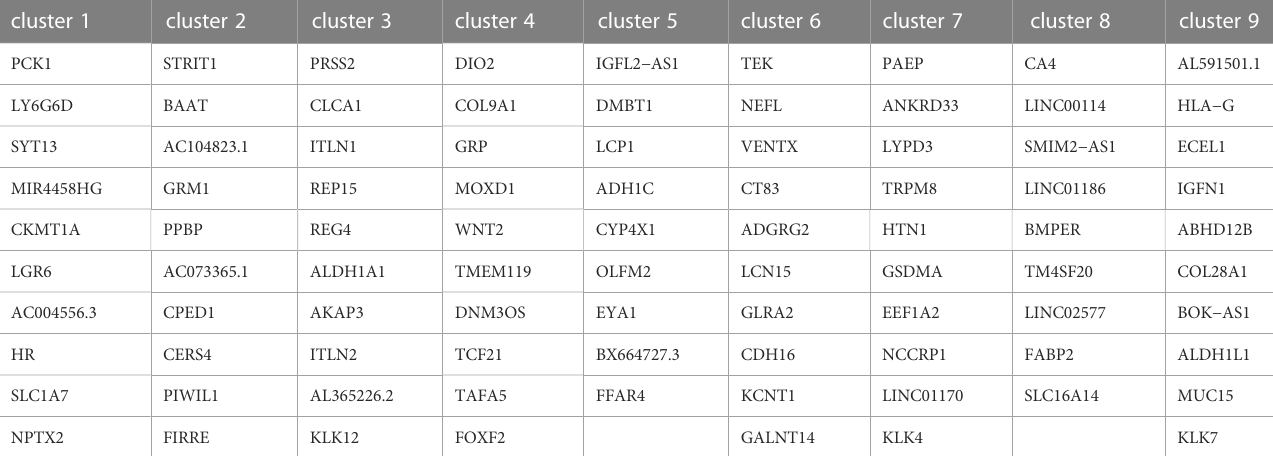
TABLE 2 Maker gene of clusters in cancerous